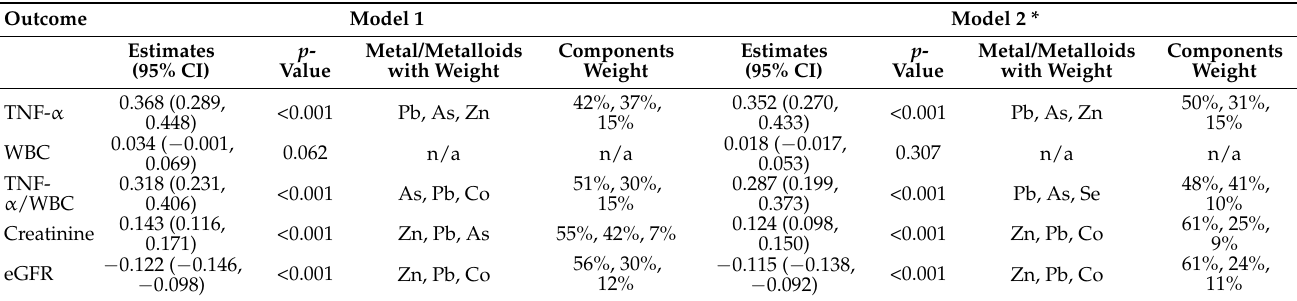
Table 3. Results of all metal mixtures by WQS regression analyses.